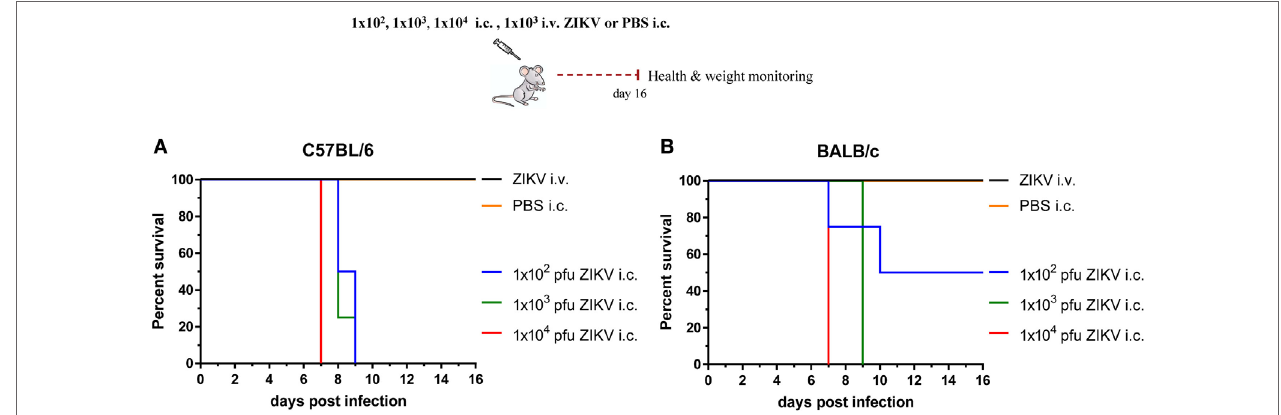
FigUre 1 | Determination of a suitable dose for i.c. challenge. Wild-type C57BL/6 (a) and BALB/c (B) mice were infected with 1 × 10 2 , 1 × 10 3 , or 1 × 10 4 pfu Zika virus (ZIKV) i.c., and their weight, health, and survival were monitored daily for 16 days. Groups of mice injected with 1 × 10 3 pfu ZIKV i.v. or PBS i.c. were included for comparison. A weight loss of 25% or more of initial body weight was used as humane end-point. n = 5 mice/group, * p <